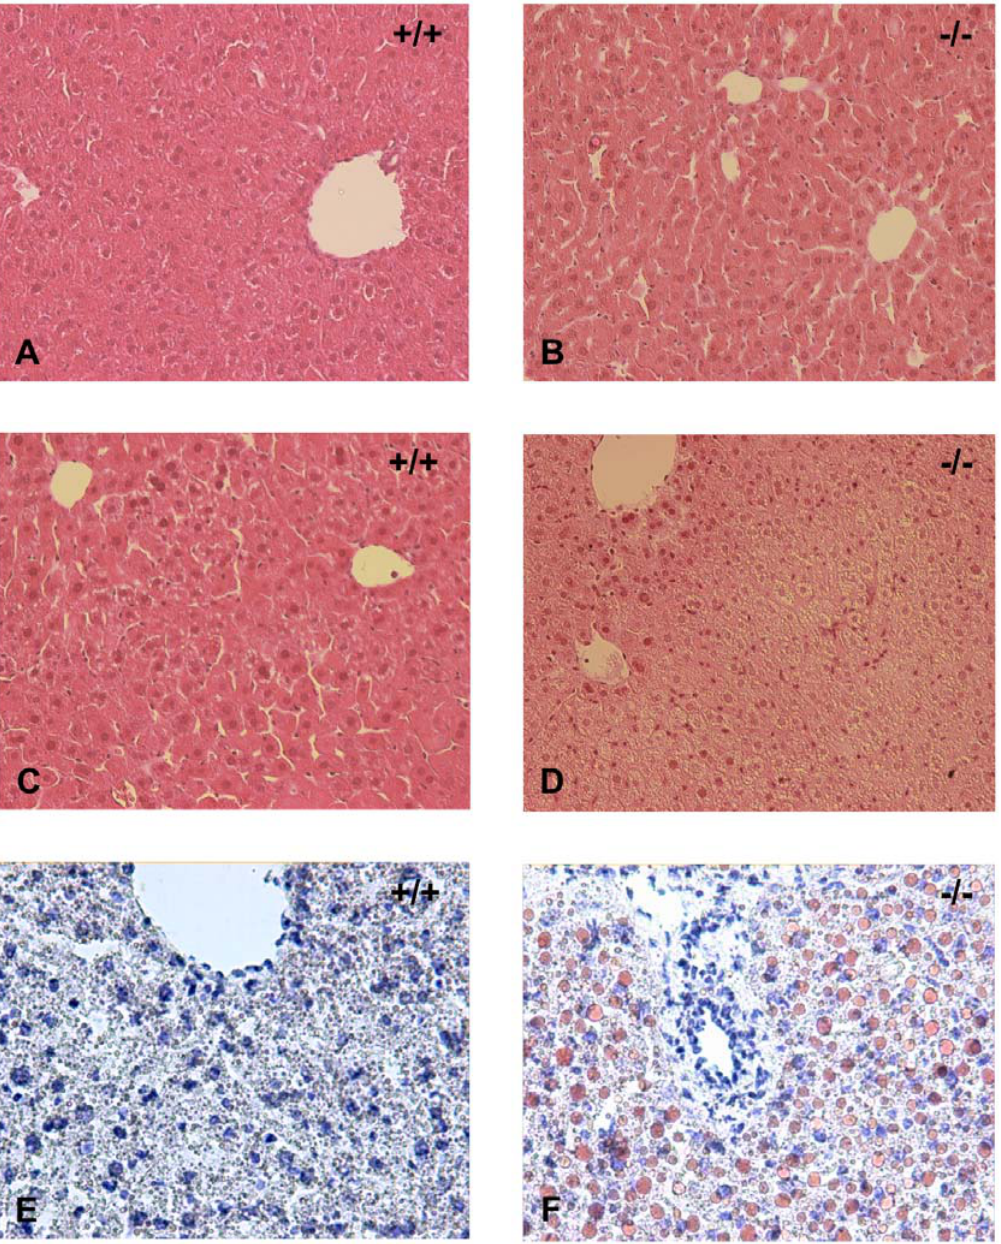
Figure 4. Histological assessment of liver morphology in fasted and non-fasted wild-type and Decr 2 / 2 mice. Light microscopic images of representative paraffin-embedded liver sections from wild type ( + / + ) and Decr 2 / 2 mice ( 2 / 2 ) stained with hematoxylin and eosin (A–D) and cryosections stained with Oil red O (E,F). Liver morphology of non-fasted animals showed no differences between wild type and Decr 2 / 2 mice (A,B). Fasting for 24 h revealed no apparent changes in the liver morphology of wild type mice, but induced microvesicular steatosis in Decr 2 / 2 mice, as observed by the appearance of foamy hepatocytes with centralized nuclei (C,D). Oil red O staining of neutral fat in representative liver cryosections revealed small, lightly stained vacuoles in the wild type sample (E), whereas a large number of intensively stained vacuoles of varying size can be seen in Decr 2 / 2 mice (F), indicating the accumulation of fat. Magnification 6 20.